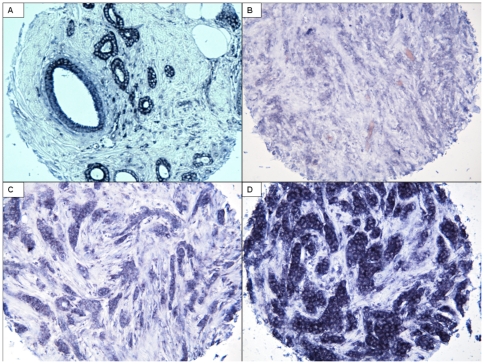
The expression of miR-34a.Benign breast epithelium (A). Category 1 (B) represents mild cytoplasmic miR-34a staining, category 2 (C) moderate staining and category 3 (D) strong staining.